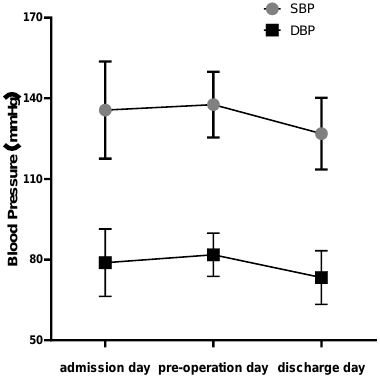
Figure 1. Trends in blood pressure. Systolic blood pressure (SBP) and diastolic blood pressure (DBP) change trends in three different timepoint during the STN-DBS perioperative period. Normal SBP < 140 mmHg; normal DBP < 90